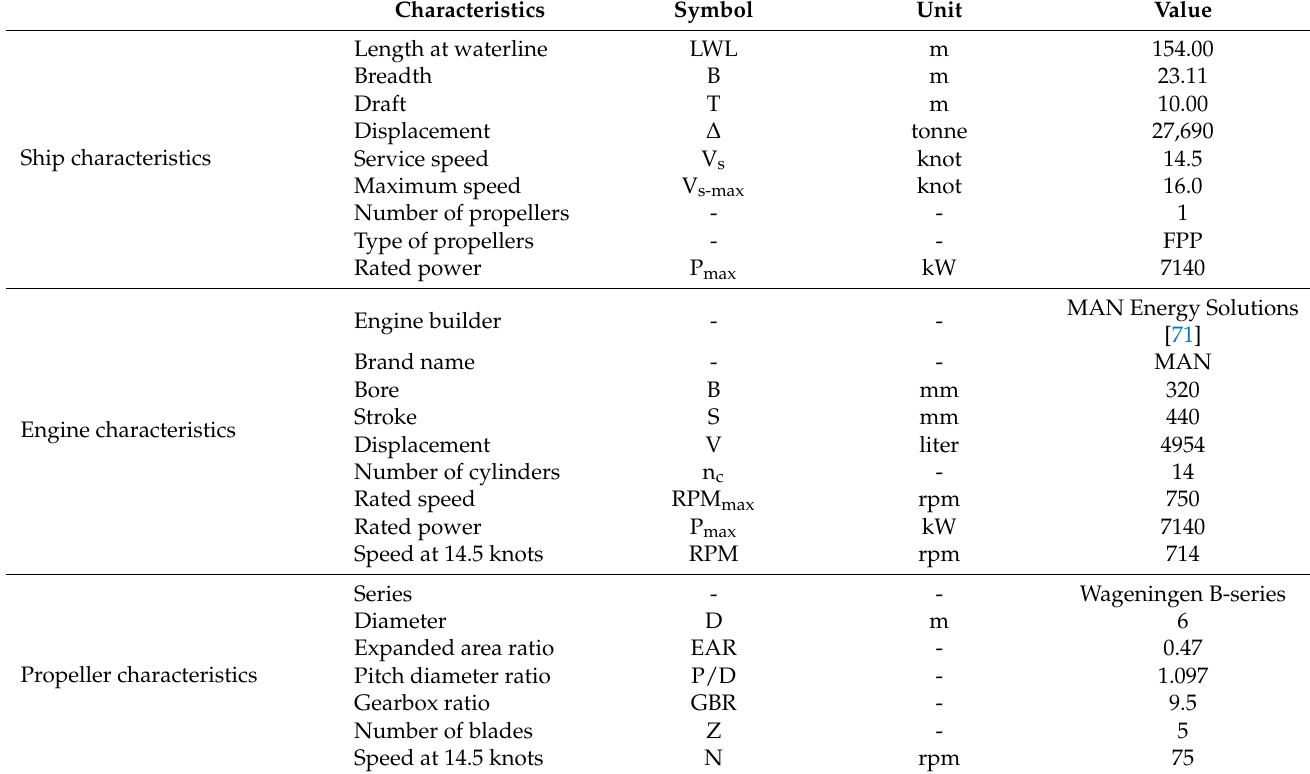
Table 1. Main characteristics of the bulk